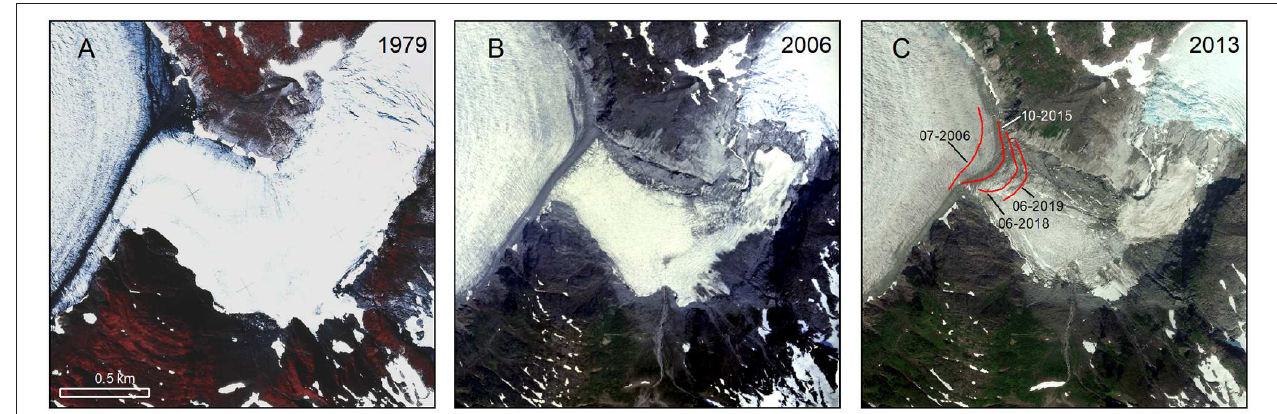
FIGURE 3 | Orthophotos from (A) 11 August 1979, (B) 3 July 2006, and (C) 28 July 2013, showing the rapid decay of Suicide Basin’s ice cover. The red lines in (C) trace the position of the former middle moraine from 2006 to 2019, revealing several hundred meters of ice motion into the basin. The WorldView-2 image shown in (C) was processed by the Polar Geospatial Center (www.pgc.umn.edu, © 2013, DigitalGlobe,